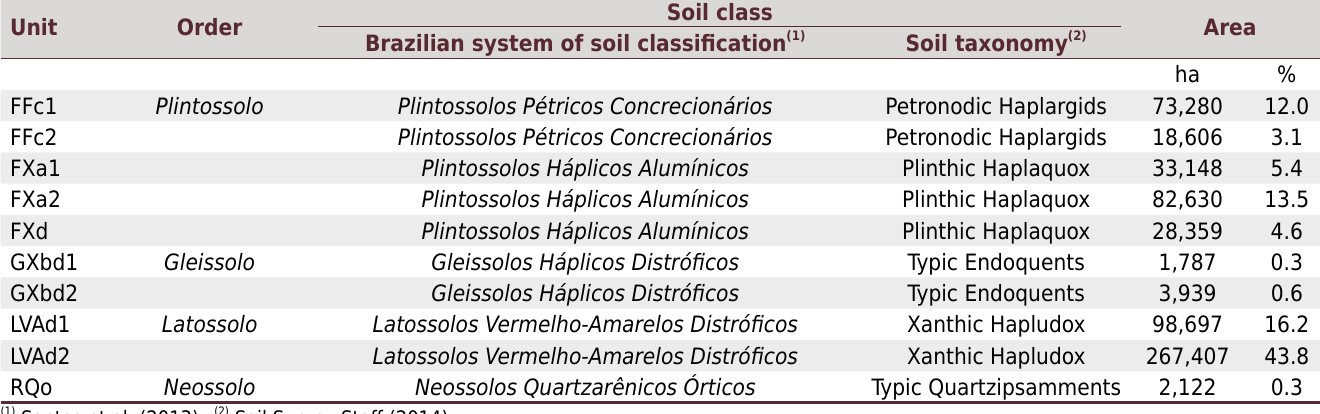
Table 1. Soil classes in the municipality of São Miguel do Araguaia, state of Goiás, Brazil Unit Order